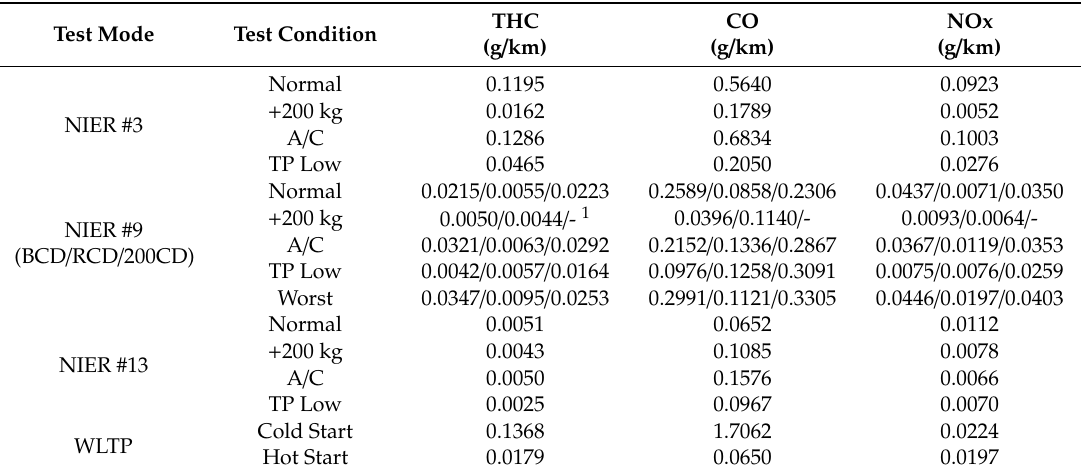
Table 5. Regulated gaseous